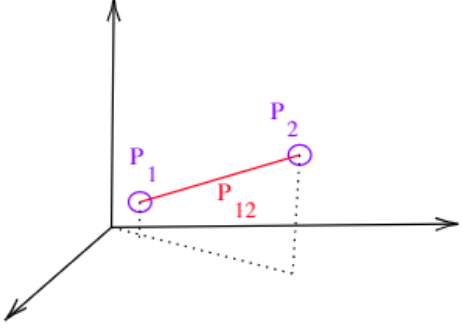
Figure 11. Simplified representation of the coordinate